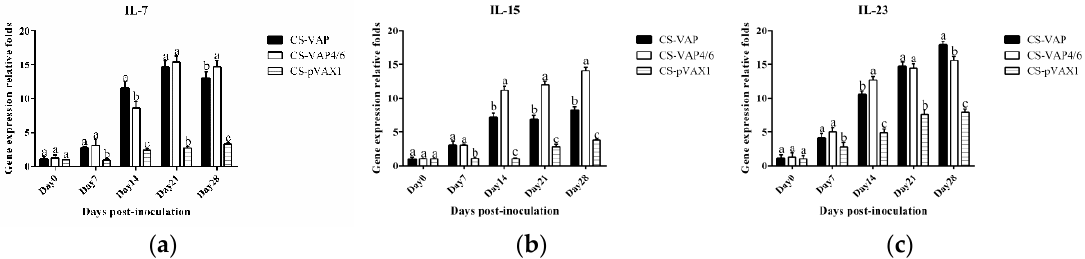
Figure 10. Expression levels of IL-7 ( a ), IL-15 ( b ), and IL-23 ( c ) immune memory genes of experimental mice. The expression levels of IL-7, IL-15, and IL-23 genes in treated groups had significant increases compared with the control group in the whole period ( p < 0.05). The group treated with CS-VAP4/6 got a higher expression level of IL-15 gene at 14 to 28 days in comparison with CS-VAP ( p < 0.05). Meanwhile, a higher expression of IL-23 gene was found in CS-VAP4/6 at 14 days compared with CS-VAP ( p < 0.05).